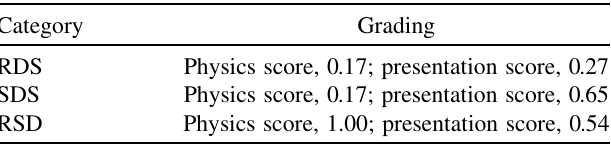
TABLE V. Final sample grades of an individual student. Category Grading